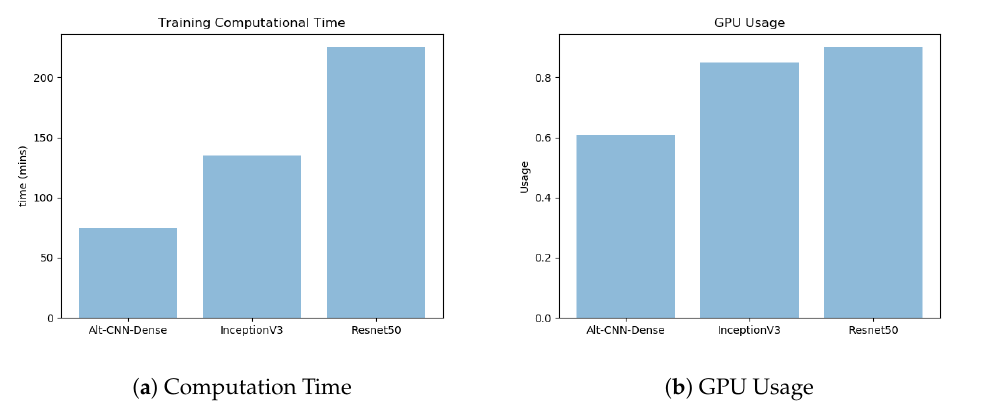
Figure 13. Comparison between ALT-CNN-Dense Net, RESNET-50 and InceptionV3 in terms of Computation time and GPU